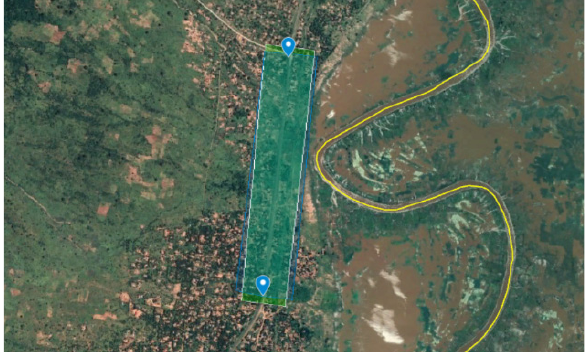
Figure 2. The area of the Nsanje district where the UAV imagery acquisition test has been performed.